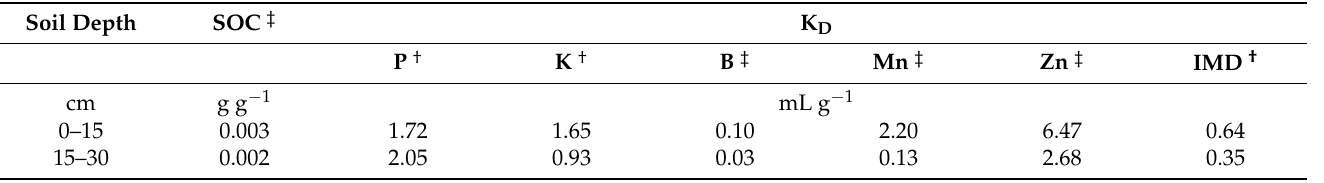
Table 1. Adsorption coefficients of nutrients and imidacloprid (IMD).